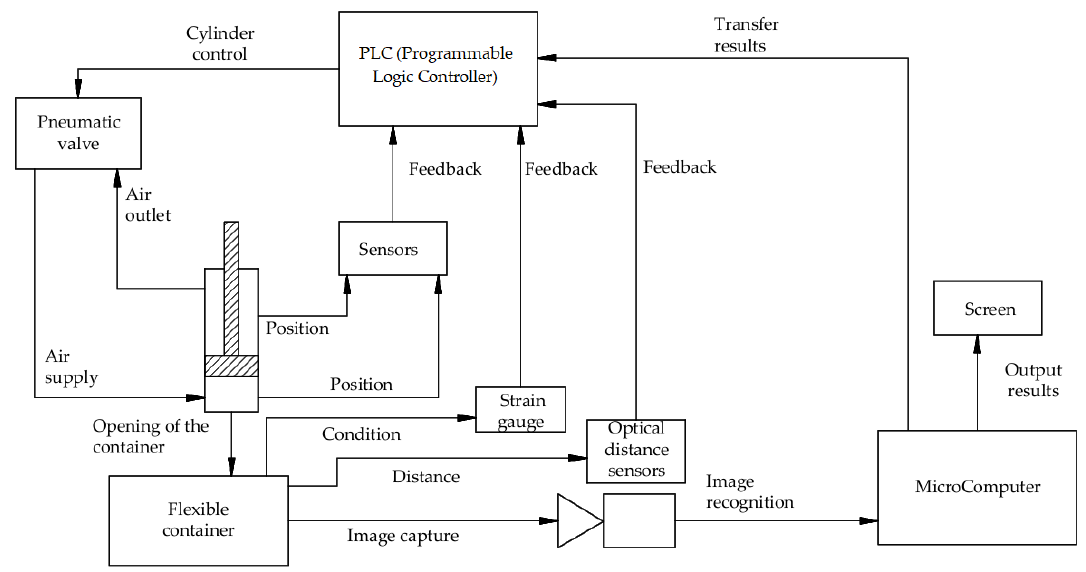
Figure 18. A block diagram of the experimental plant.